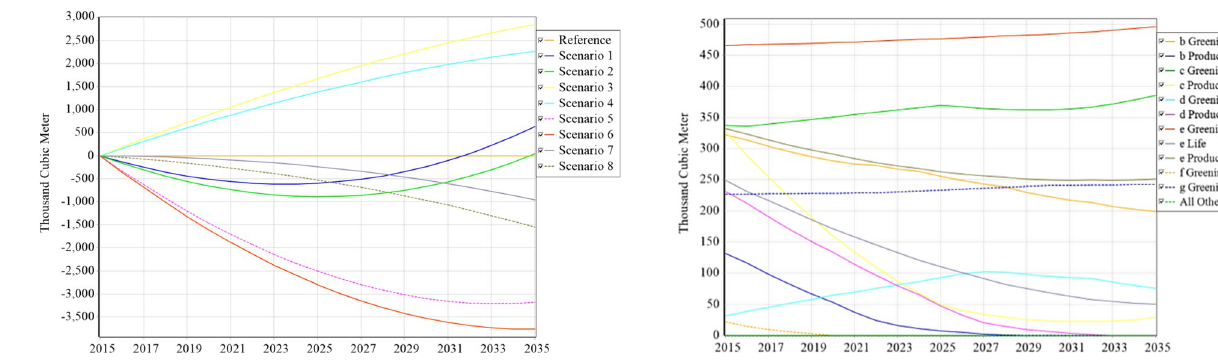
Fig. 4 Changes in water demand from 2015 to 2035